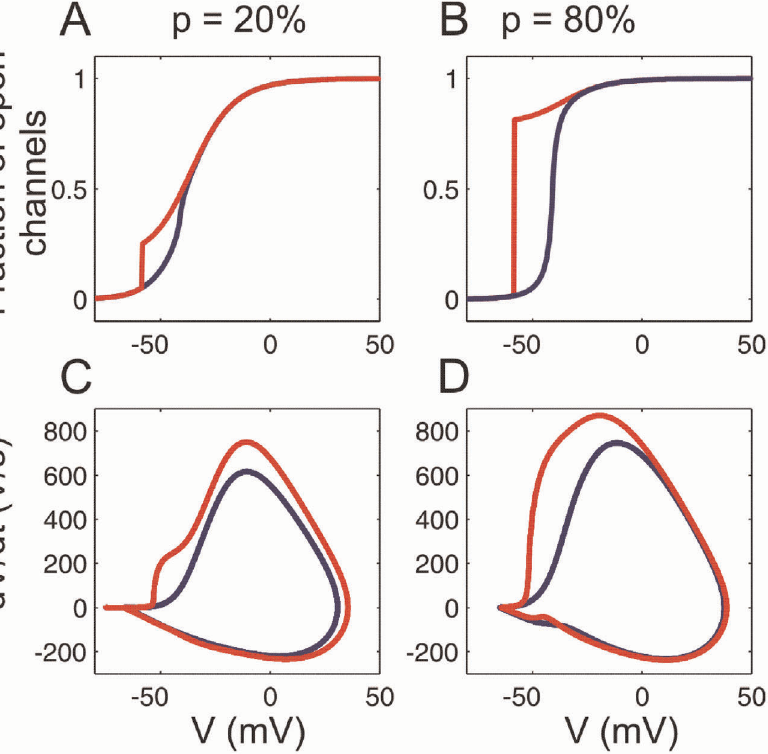
Figure 3. Channel activation and AP dynamics in models with cooperative sodium channels. ( A,B ) Activation curves of sodium channels and ( C.D ) AP phase plots for the models with a small ( p ~ 20% ) and a large ( p ~ 80% ) fraction of cooperative channels, and a weak coupling ( KJ ~ 20 mV , blue traces) or strong coupling ( KJ ~ 320 mV , red traces).